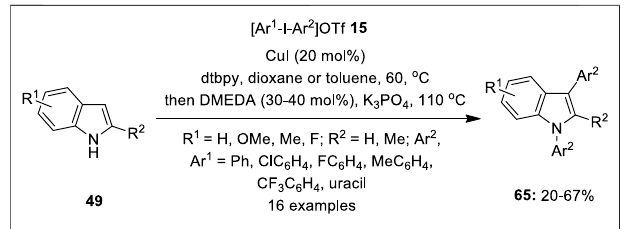
Frontiers in Chemistry |